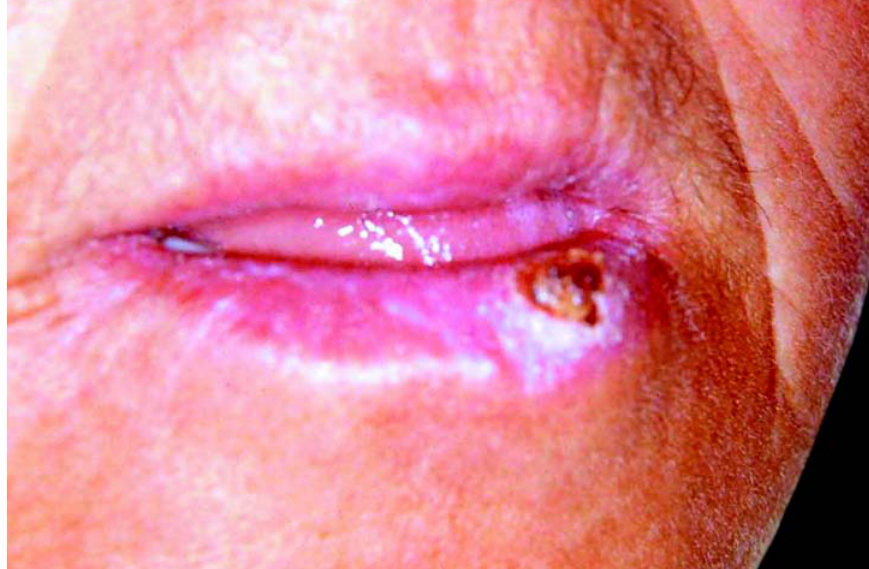
FIGURE 3- Clinical aspect of the lesion after the initial surgical intervention (biopsy), demonstrating partial regression compared to Figure 1